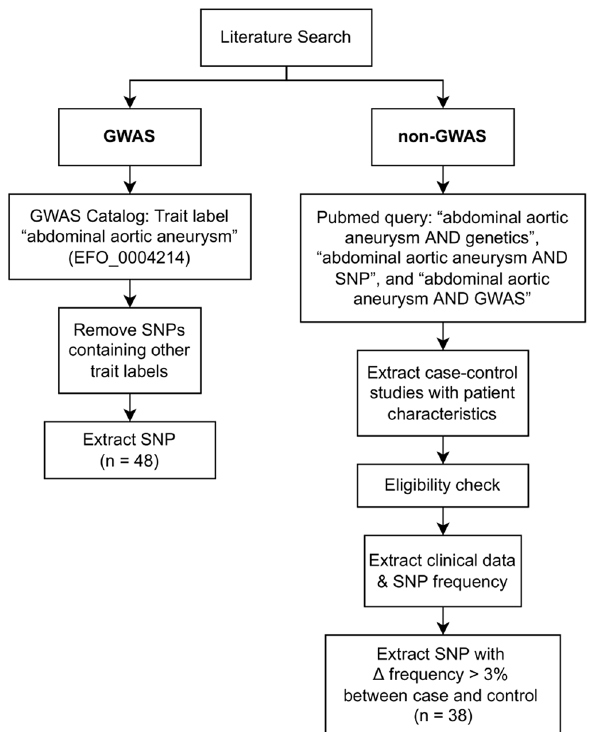
Figure 1. Flow diagram of study inclusion for the